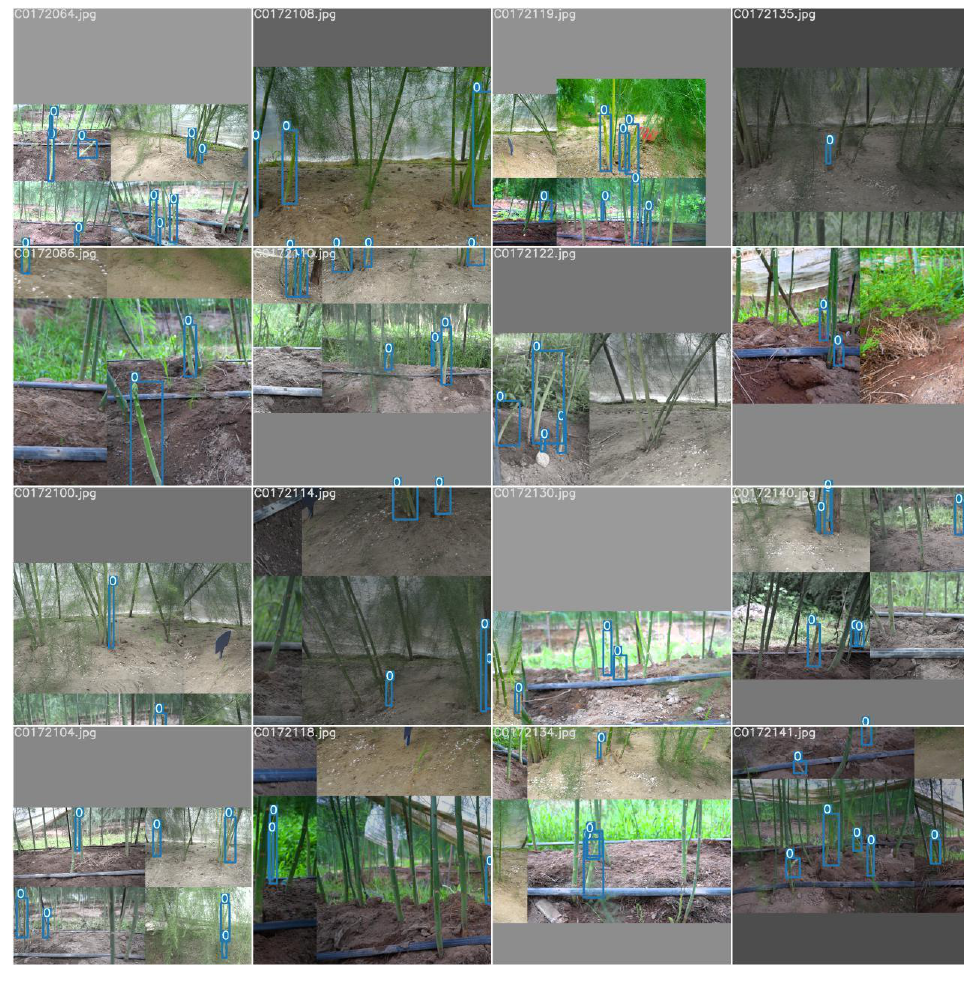
Figure 11. Mosaic data enhancement.